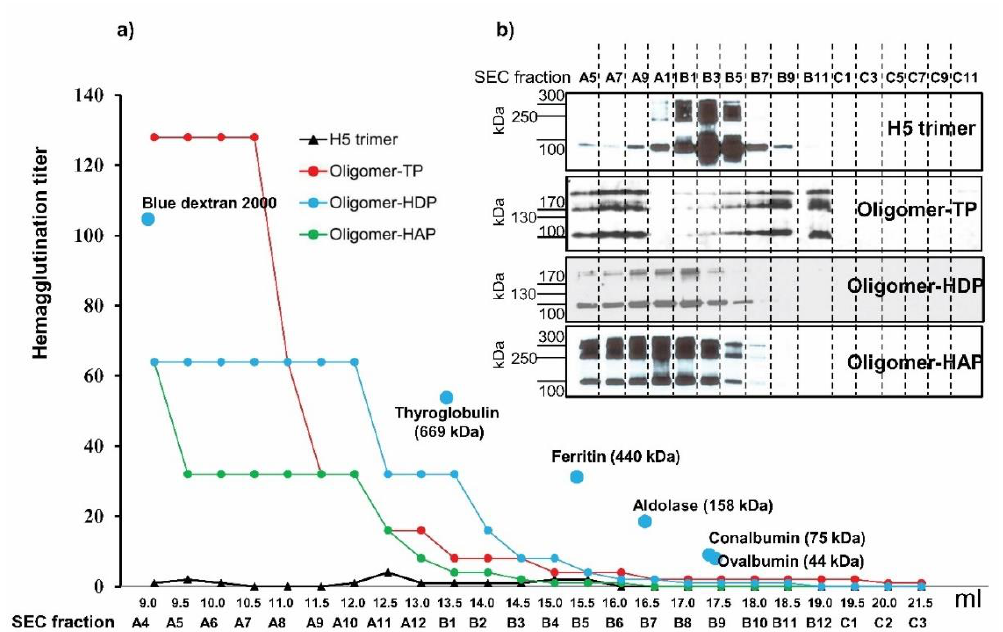
Figure 4. Characterization of H5 trimer and H5 oligomers by size exclusion chromatography. IMAC-purified H5 trimers and three H5 oligomers were separated on Superose ™ 6 increase 10 / 300GL according their sizes. The standard proteins loaded on the column to estimate the native molecular weights of target proteins are presented by light blue dots. SEC fractions of H5 trimer, H5 oligomer-TP, oligomer-HDP, and oligomer-HAP were analyzed by hemagglutination assay ( a ) and Western blot ( b ). The hemagglutination titer of each single fraction (from A4 to C3) of H5 trimer, H5 oligomer-TP, oligomer-HDP, and oligomer-HAP are given. Presence of hemagglutinin proteins in the SEC fractions was confirmed by Western blotting by use of an anti-c-Myc monoclonal antibody.